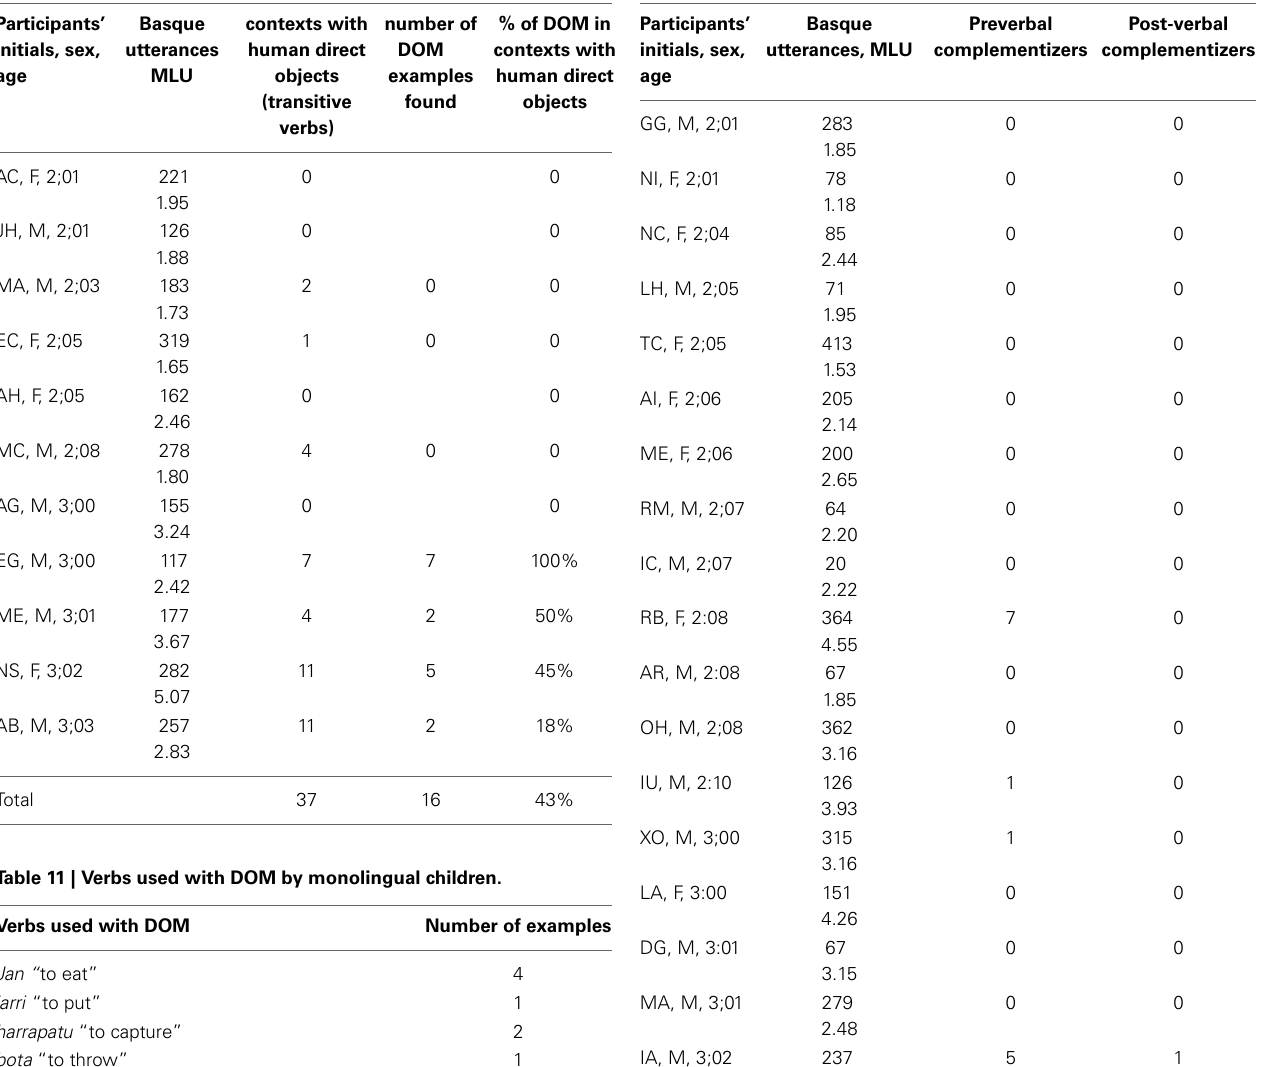
Table 12 | Use of preverbal complementizers (bilingual